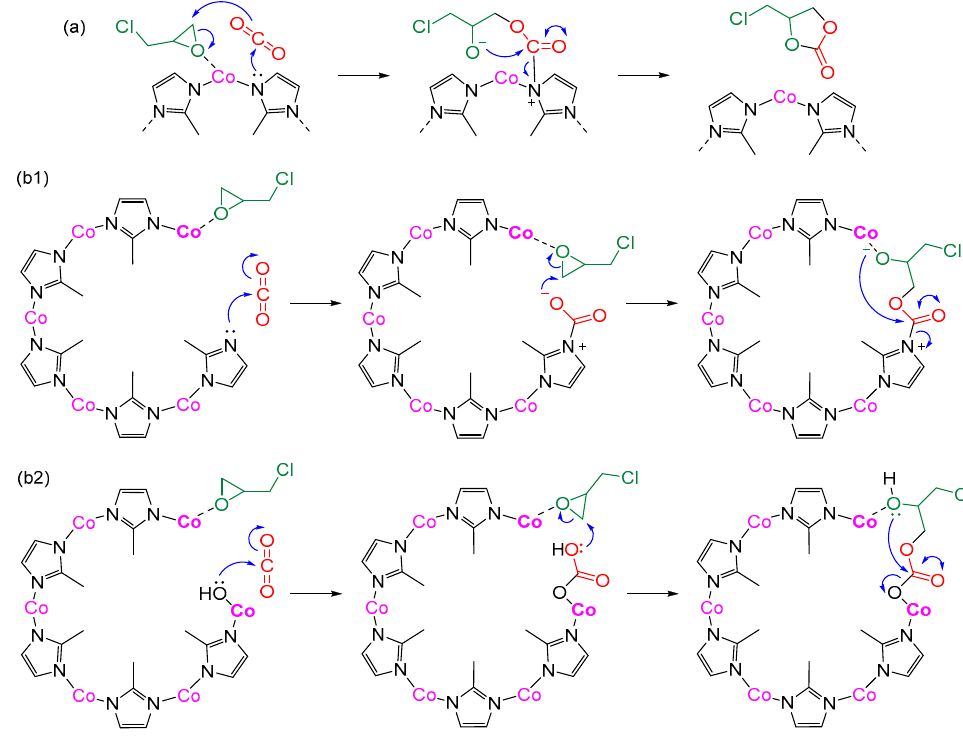
Figure 9. ( a ) Classical reaction mechanism for the cycloaddition of epichlorohydrin and CO 2 catalyzed by ZIF-67. ( b ) Proposed reaction mechanism with ZIF-67 involving structural defects. ( b1 ) CO 2 activation by a partially coordinated 2-methylimidazole unit. ( b2 ) CO 2 activation by a superficial hydroxyl group.